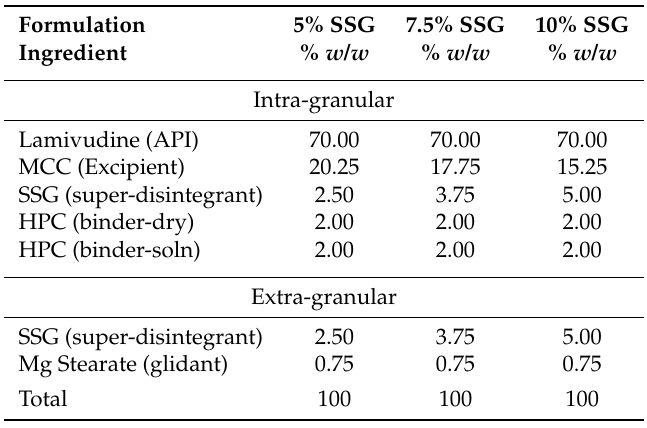
Table 1. Formulation compositions for fluid-bed wet granulation batches.